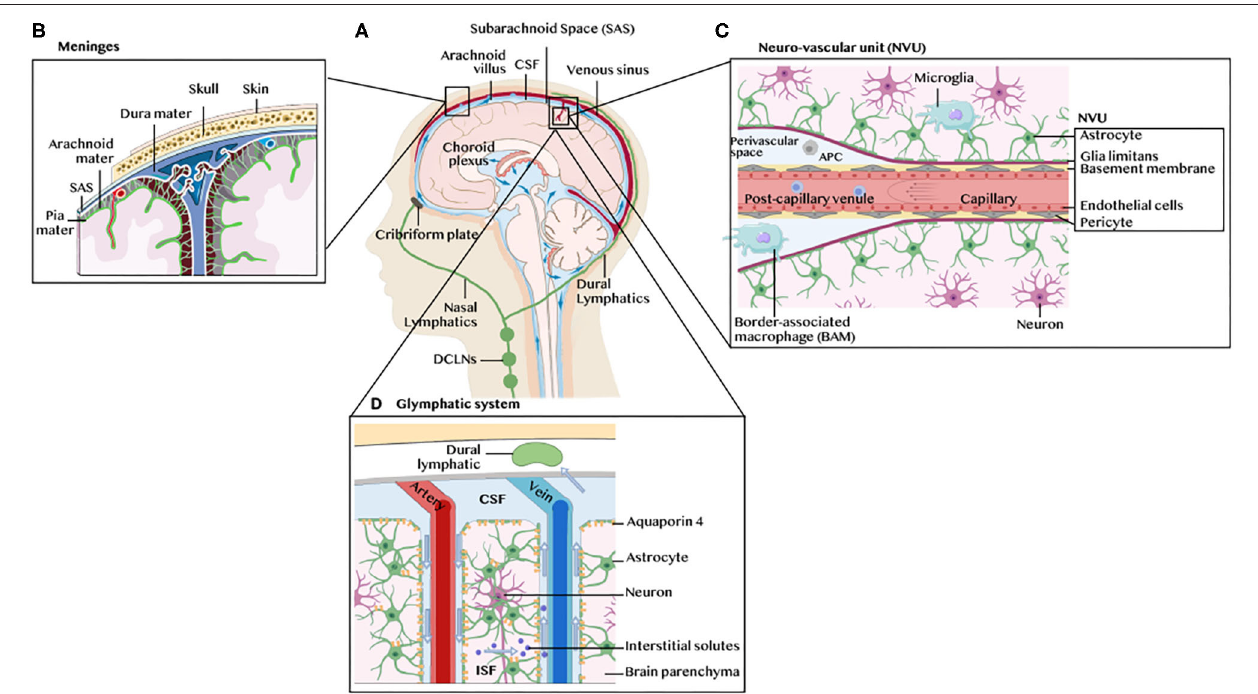
FIGURE 1 | Architecture of the CNS immune system. (A) Schematic illustration of the human brain anatomy namely the brain parenchyma, choroid plexus, ventricles, cerebrospinal fluid (CSF), meninges, dural and nasal lymphatics and the deep cervical lymph nodes (DCLNs). (B) The meninges. These are three membranes that envelop the brain, namely the dura mater, the arachnoid membrane and the pia mater. (C) The neurovascular unit (NVU), blood brain barrier (BBB) and perivascular space. The glia limitans formed by astrocytes end feet ensheath the capillary basement membrane and its pericytes. The perivascular space contains microglia-like perivascular macrophages also dubbed border-associated macrophages (BAMs) and antigen-presenting cells (APC). Microglia are found in the brain parenchyma. (D) The glymphatic system. The CSF enters the brain parenchyma through aquaporin 4, water channels on the end-feet of astrocytes surrounding the vasculature, and communicates with the interstitial fluid (ISF) carrying solutes and small antigens through the glymphatic system, a network of perivascular channels formed by astroglia for waste